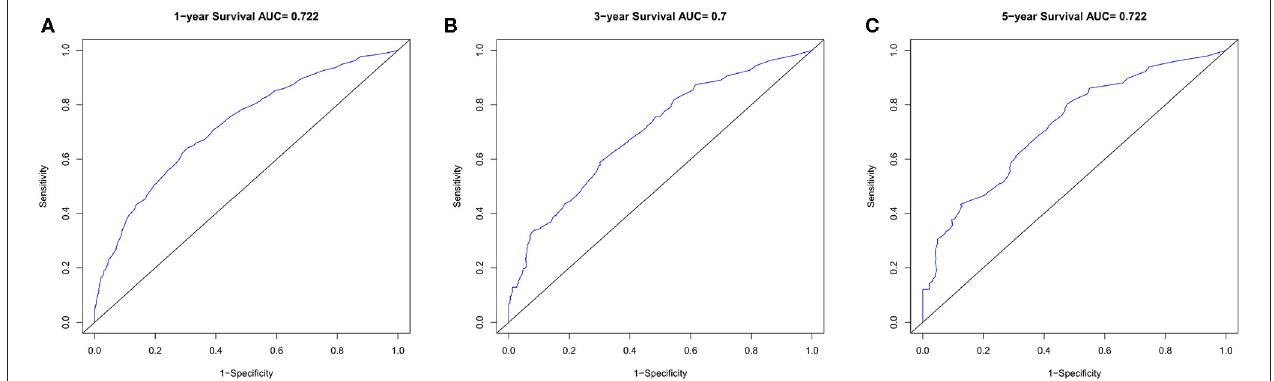
FIGURE 5 | The ROC curves in training cohort. (A) 1-year, (B) 3-years, (C) 5-years survival ROC